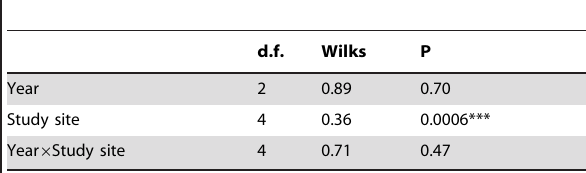
Table 3. Inter-site variability in aromatic plant species composition of blue tit nests, as tested by a Manova on the PC1, PC2 and PC3 scores from a Principal Component Analysis on relative abundances of aromatic species in 115 nests (see Materials and